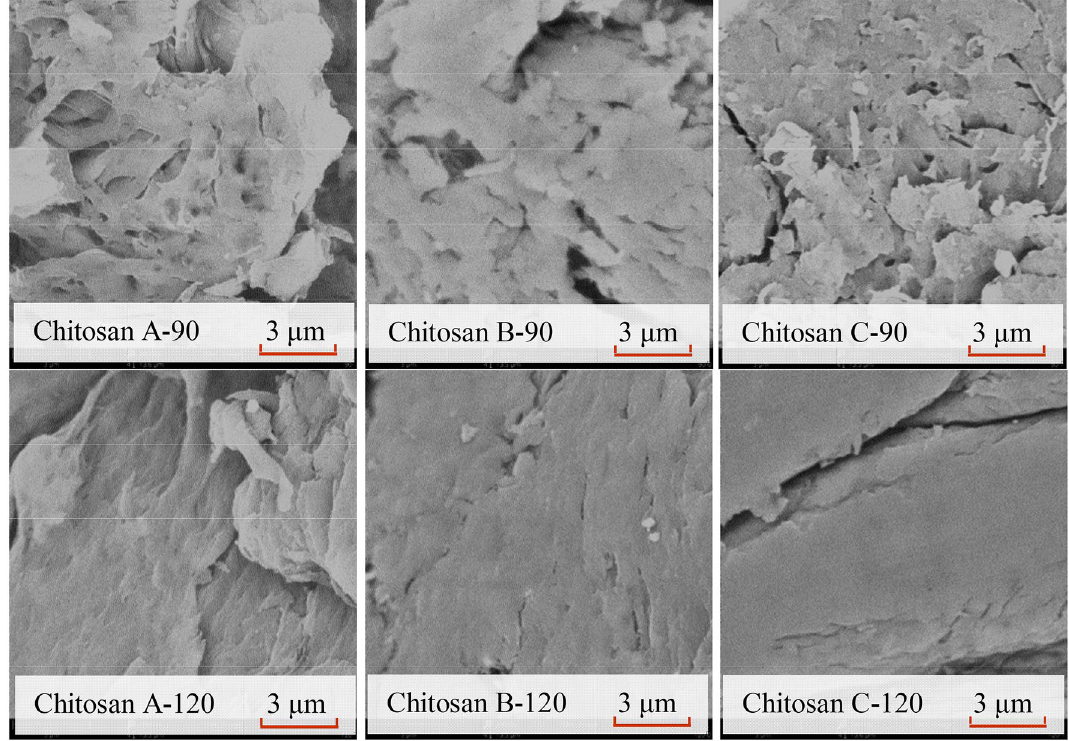
Figure 4. SEM images of crab shell chitosan by deacetylation at 90 °C and 120